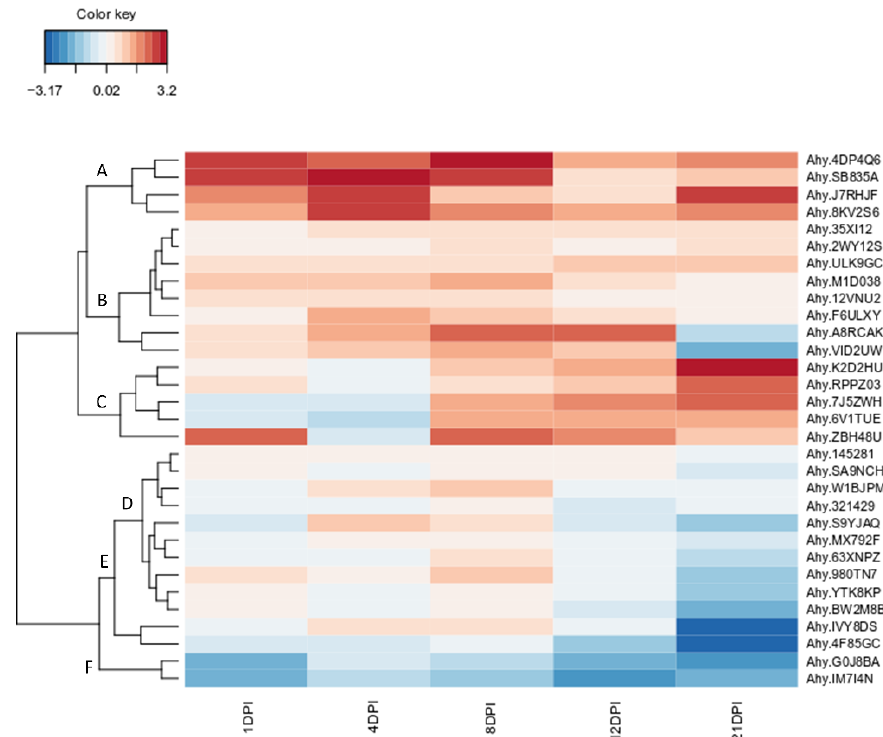
Figure 5. Heatmap analysis of the AhLysM-RLK gene expression during symbiosis development: 1 dpi (recognition and invasion), 4 dpi (primordia formation), 8 dpi (nodule-like structure), 12 dpi (immature nodules with rod-shaped rhizobia), and 21 dpi (mature nodules with spherical symbiosomes). Greyscale legend represents the log2FC calculated relative expressions. Figure was drawn using R.